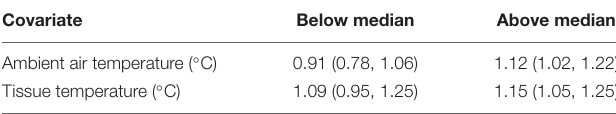
Relative change in geometric mean with corresponding 95% confidence intervals for trh, subsetting data based on whether temperatures are above or below their respective overall